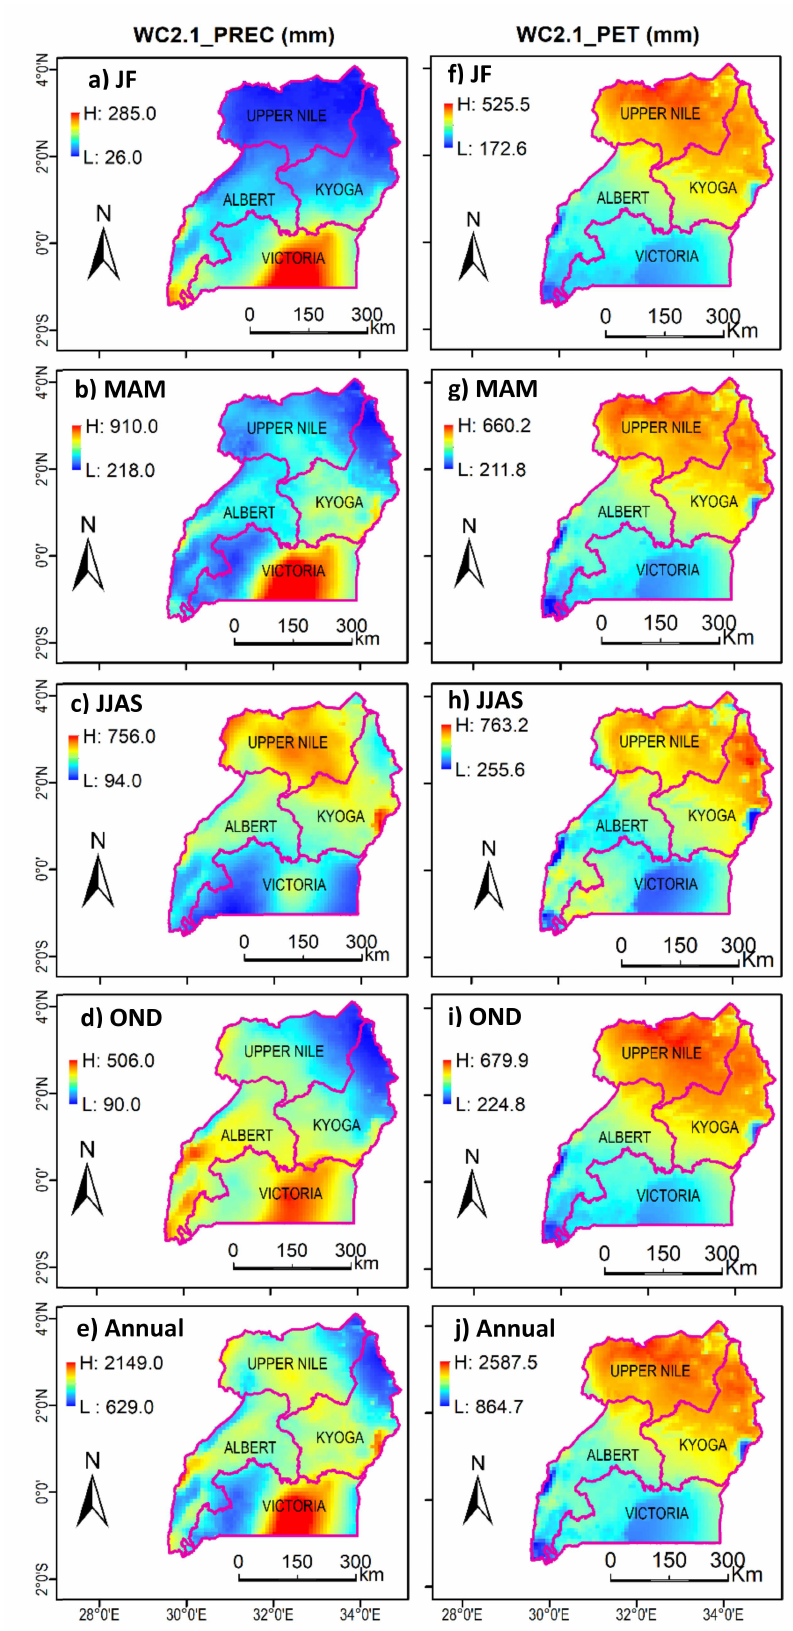
Figure 2. Historical annual and seasonal ( a – e ) precipitation and ( f – j )